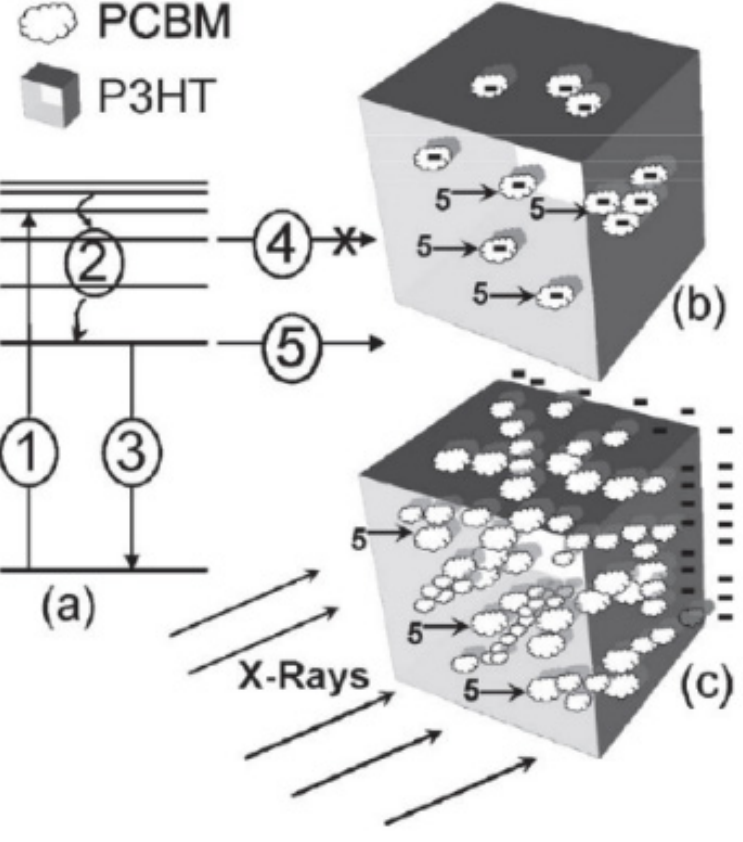
Figure 14. Physical model of the effect of X-rays on polymer solar cells: ( a ) scheme of electronic levels and transitions in a molecule: 1: excitation, 2: internal deactivation, 3: transition to the ground state, 4: dissociation from higher excited states and 5: dissociation from the first excited level; ( b ) a low PCBM % bulk P3HT:PCBM film showing isolated PCBM domains; ( c ) a high PCBM% bulk P3HT:PCBM film showing well connected PCBM network, resulting in good charge transport. Copyright permission from [138].